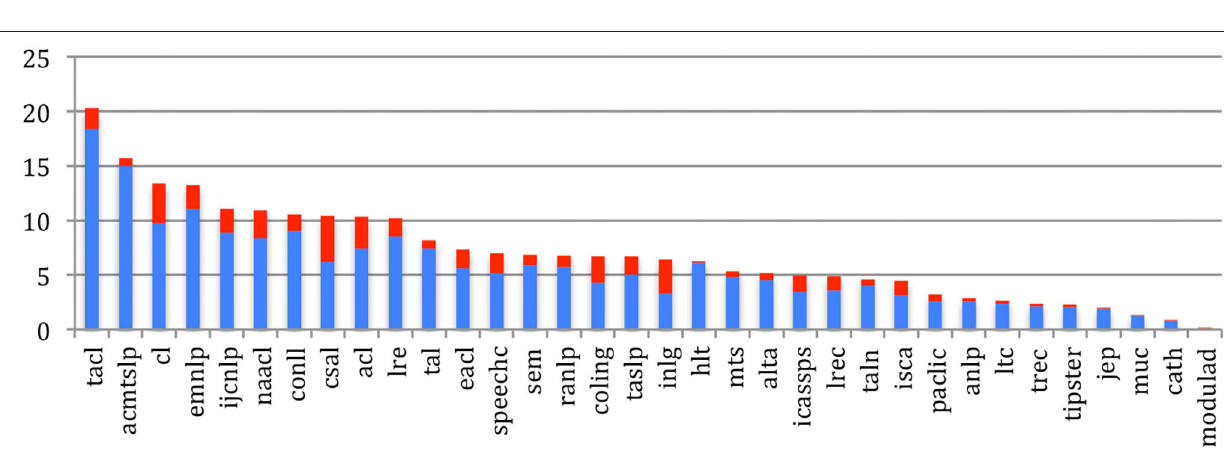
FIGURE 23 | Mean Degree of papers citing papers in general for the 34 sources in 2015 (blue) and 2020